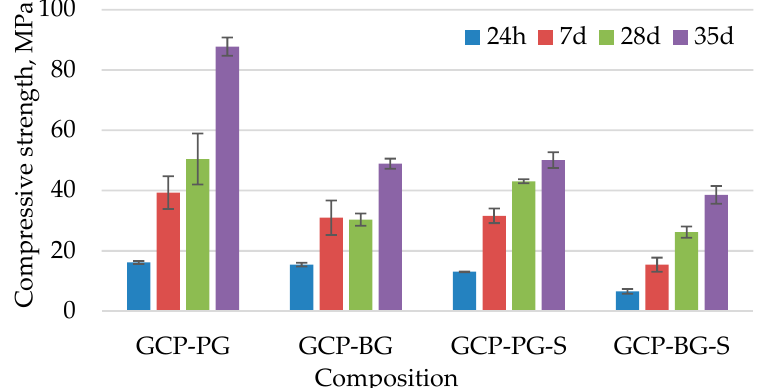
Figure 6. The compressive strength of ternary binder and mortar.